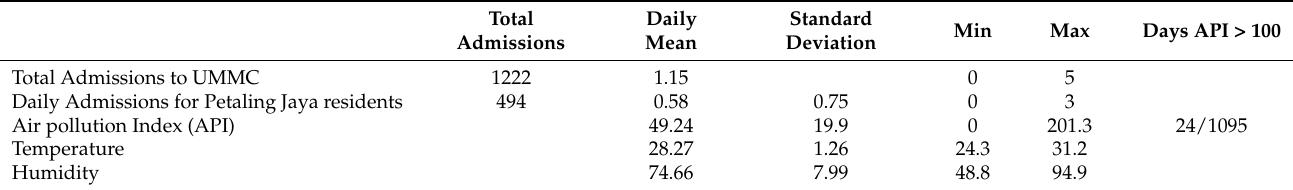
Table 1. Summary Statistics for admissions to UMMC for respiratory conditions and air quality, temperature, and humidity for Petaling Jing,